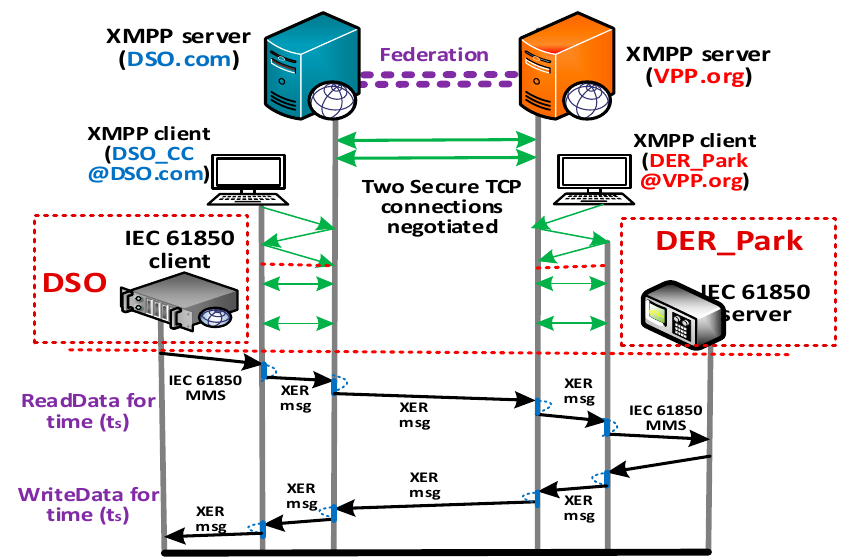
Figure 8. Message flow between DSO and DER_Park using Federation (Case II).